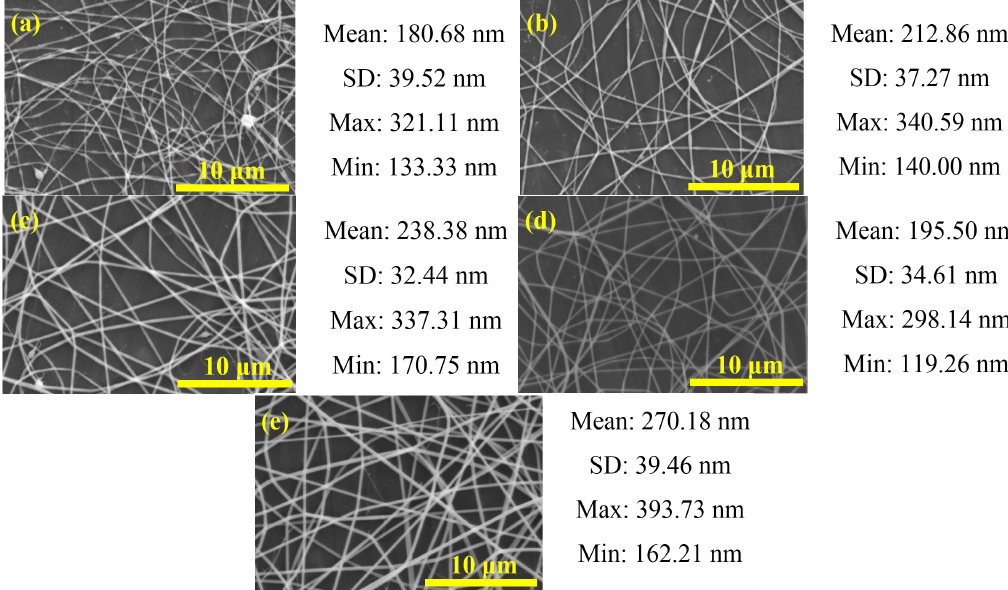
Figure 3. Scanning electron microscopy (SEM) images of PbI 2 /PVP composite fibers produced from precursor solutions with different PVP concentration: ( a ) 3.08; ( b ) 3.58; ( c ) 4.07; ( d ) 4.55 and ( e ) 5.03 wt% (V = 15 kV, L = 10 cm, FR = 1.0 mL/h). The figure also shows the mean, standard deviation (SD), maximum and minimum values of the fiber diameter.